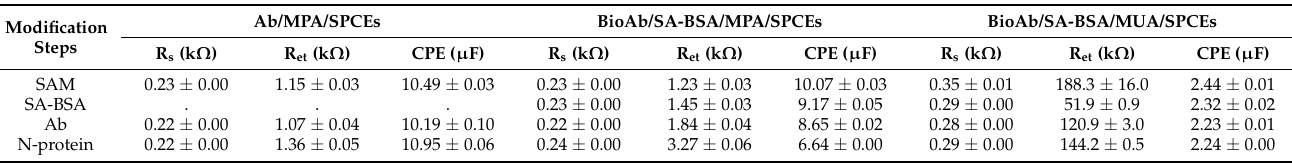
Figure 1. Nyquist plots of immunosensor preparation and 1 ng/mL N-protein immunoreaction of Ab/MPA/SPCE ( a ), BioAb/SA-BSA/MPA/SPCE ( b ), and BioAb/SA-BSA/MUA/SPCE ( c ) measured in a 10 mM PBS solution containing 2.5 mM equimolar Fe(CN) 63 − /4 − . The inset in ( a , c ) shows the Nyquist plot of bare AuNS/SPCEs. ( d ) Nyquist plots of time-dependent immunoreaction of 1 ng/mL N-protein on the BioAb/SA-BSA/MPA/SPCEs. Inset shows the time-dependent R et increment ( ∆ R et = R et-N-protein − R et-Ab ). Table 1. The electric element values fitted from the experimental spectra of Figure 1a–c. Each data is calculated from three individual